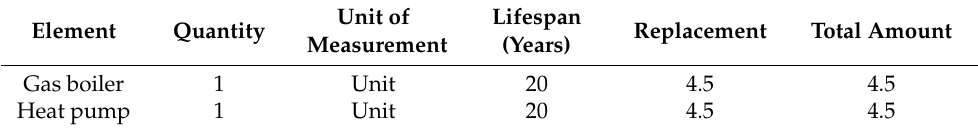
Table 8. Inventory of the heating and cooling systems.